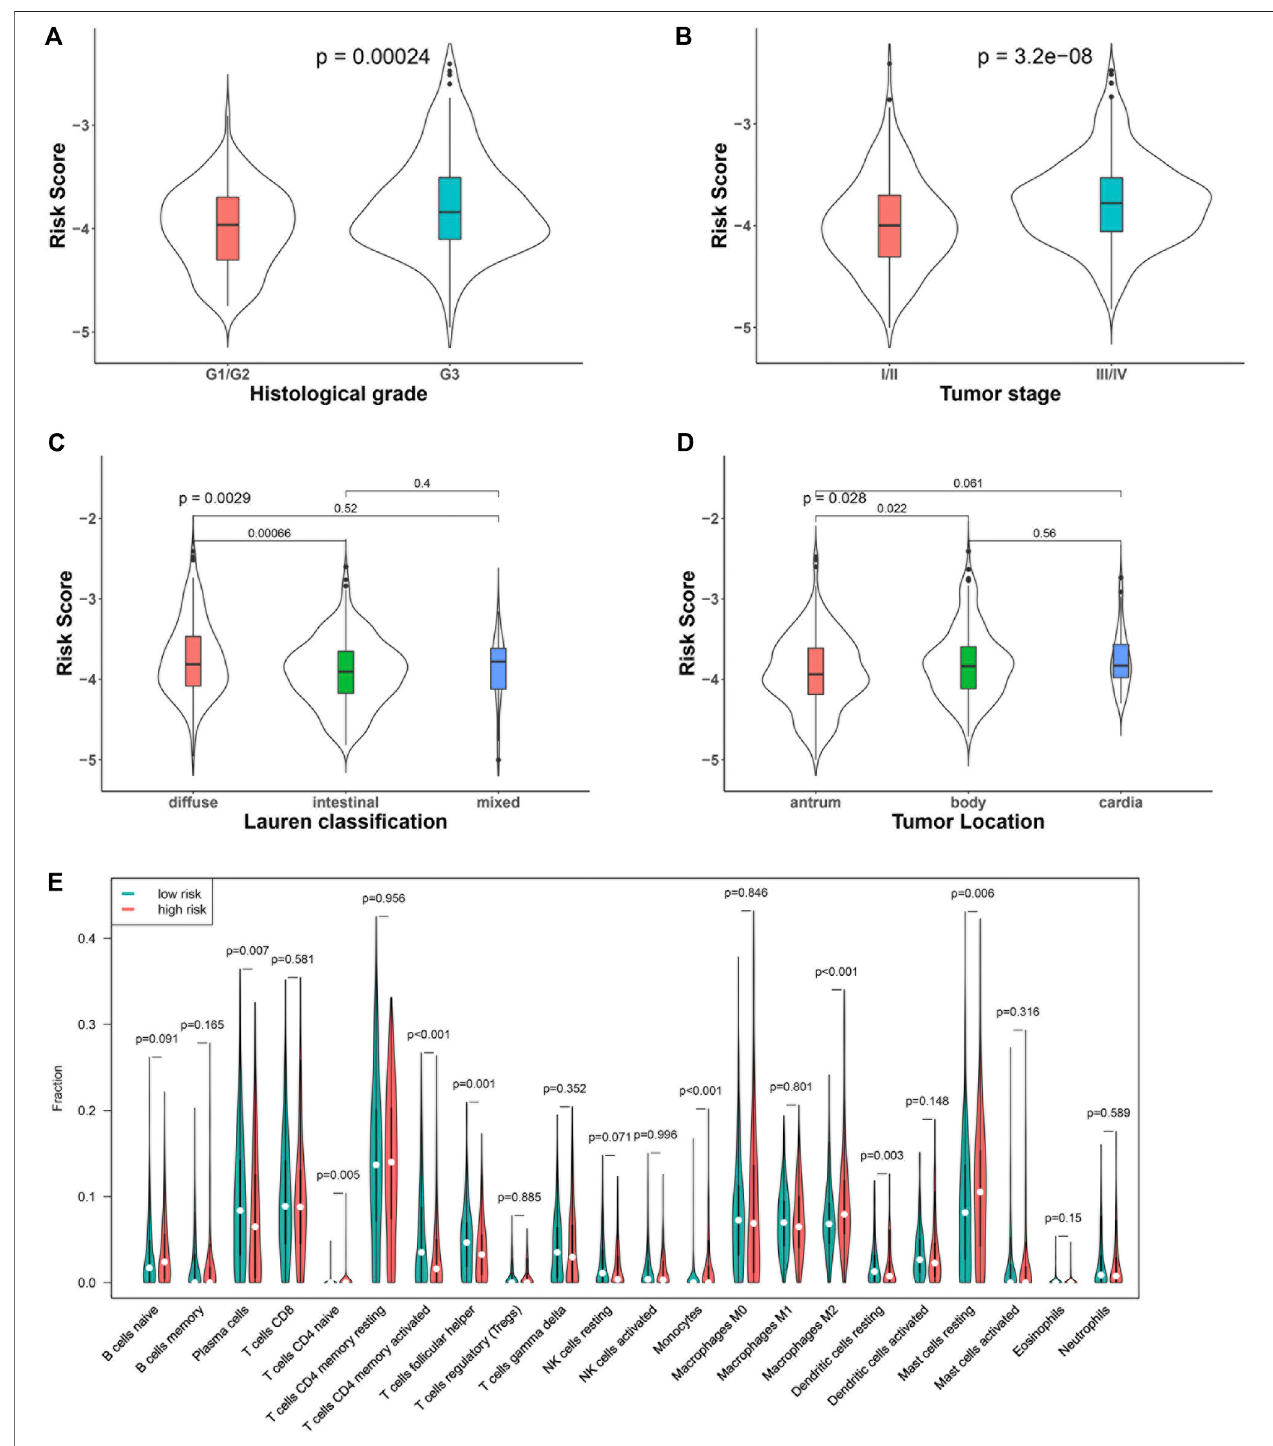
FIGURE2| Associationoftheriskscorewithclinicalcharacteristicsandimmunecells:tumorgrade (A) ,stage (B) ,Laurenclassi fi cation (C) ,tumorlocation (D) ,and immune cell subtypes (E) .